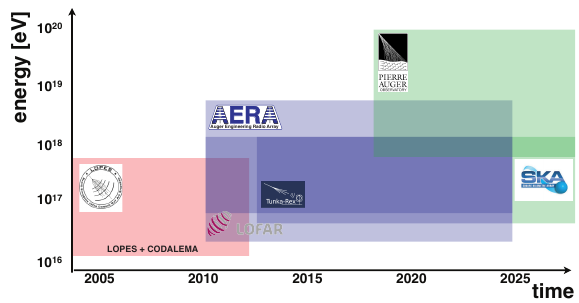
Figure 14. Schematic view of the development of the radio de- tection technique. The approximate energy range for various ex- perimental set-ups is plotted versus the approximate operation time of those